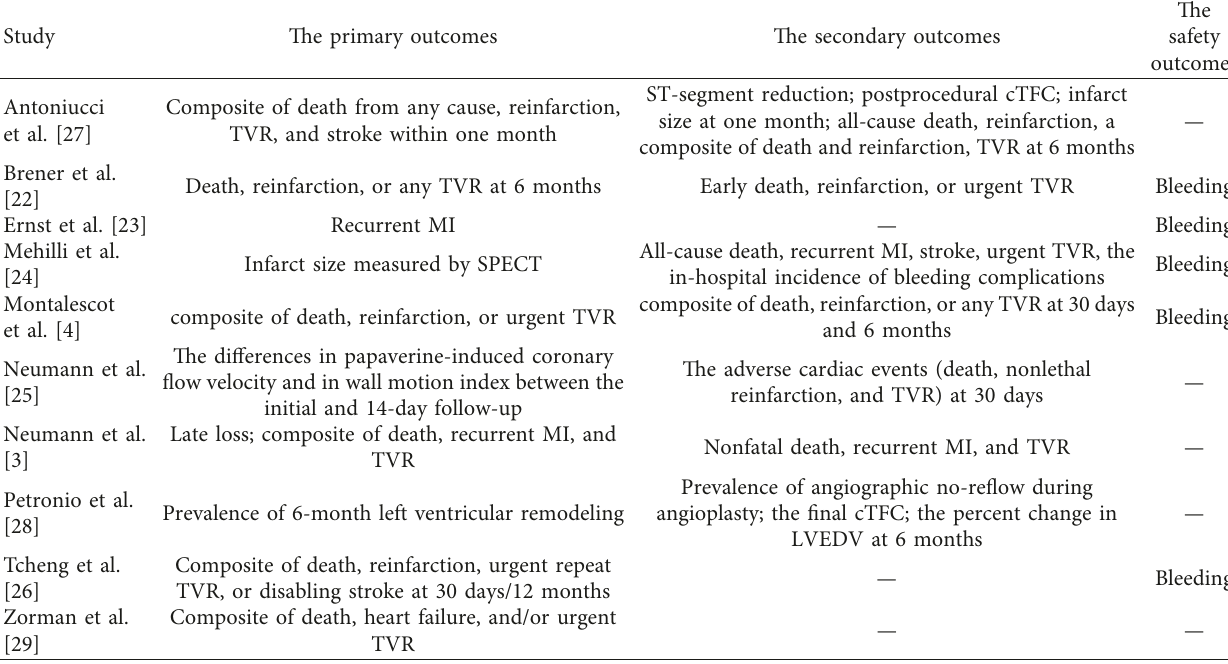
Table 2: Outcomes of the trials